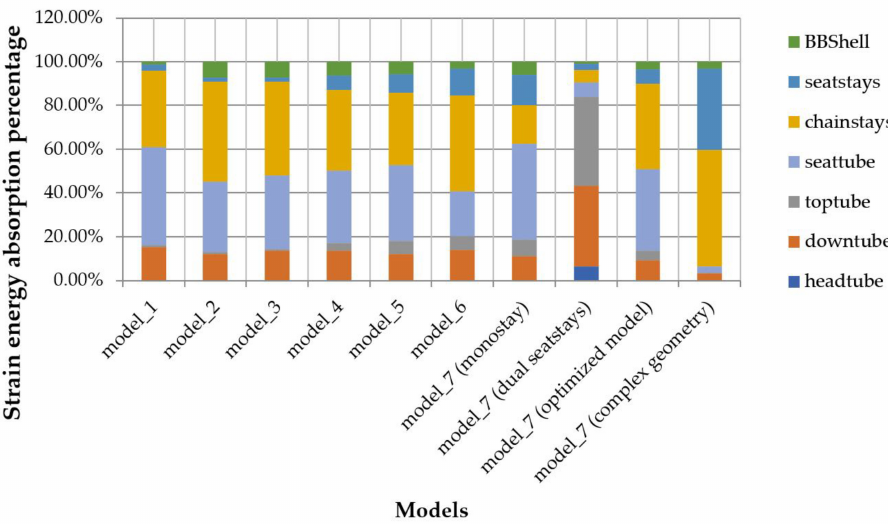
Figure 25. Absorption of strain energy and its distribution in the riding